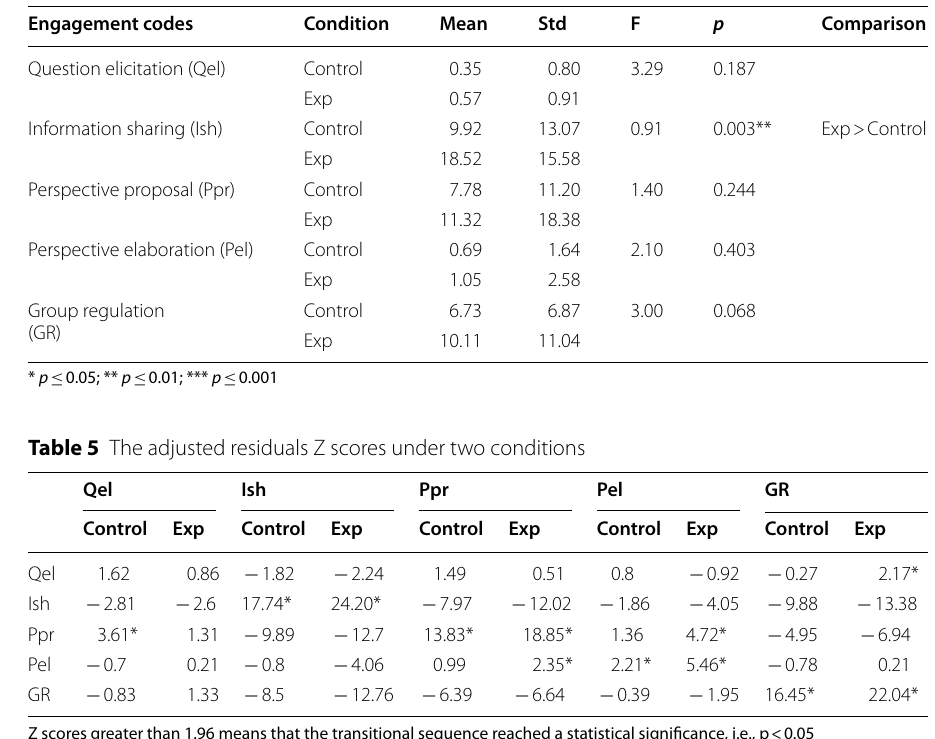
Table 4 The t-test comparison of engagement codes between two conditions